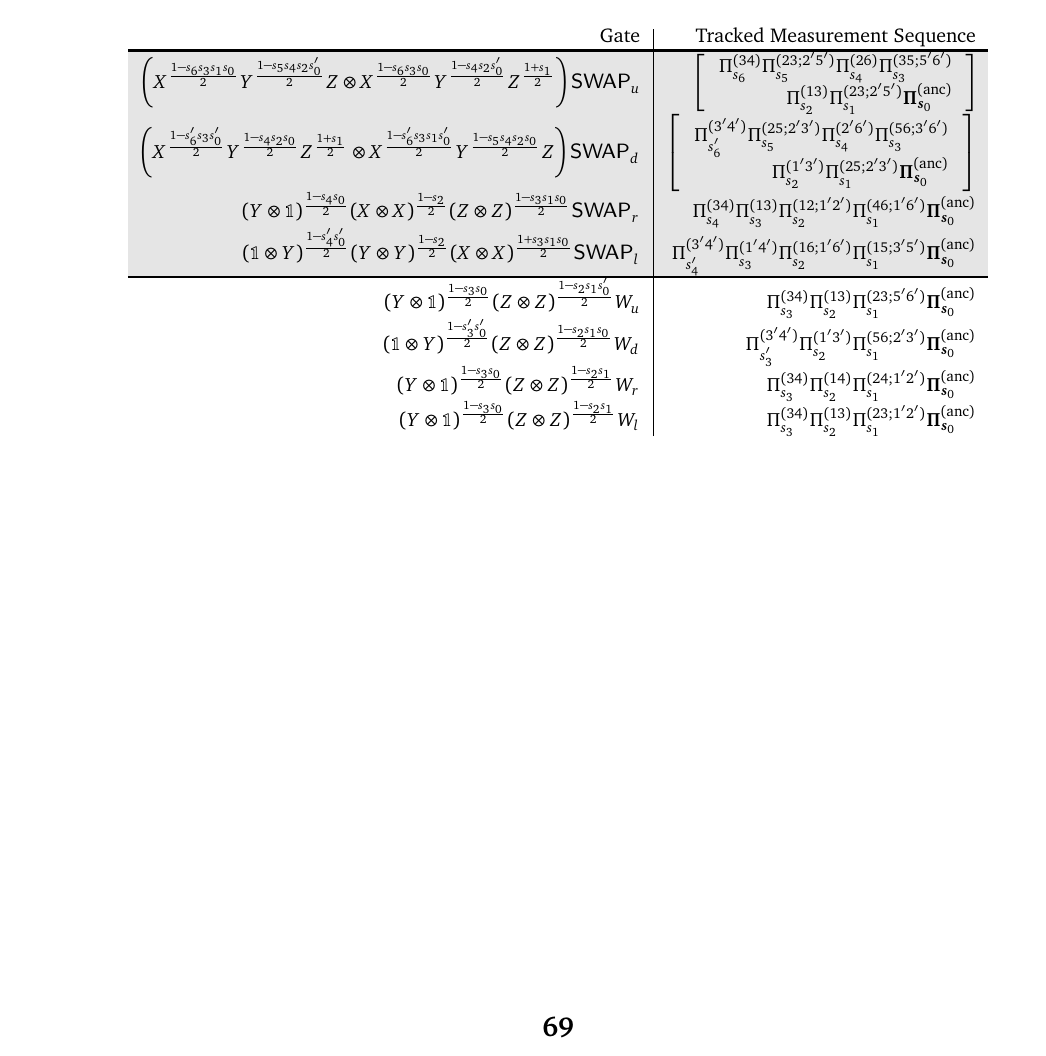
Table 28: Pauli gate corrections tracked for the corresponding SWAP and W gates implemented using Majorana-Pauli tracking methods. The implicit action on the for sequences of length n . (When s (cid:48) 0 there is not a final projector for one of the ancillary pairs, it is equivalent to there being a projector for that ancillary pair onto its initial projection channel,